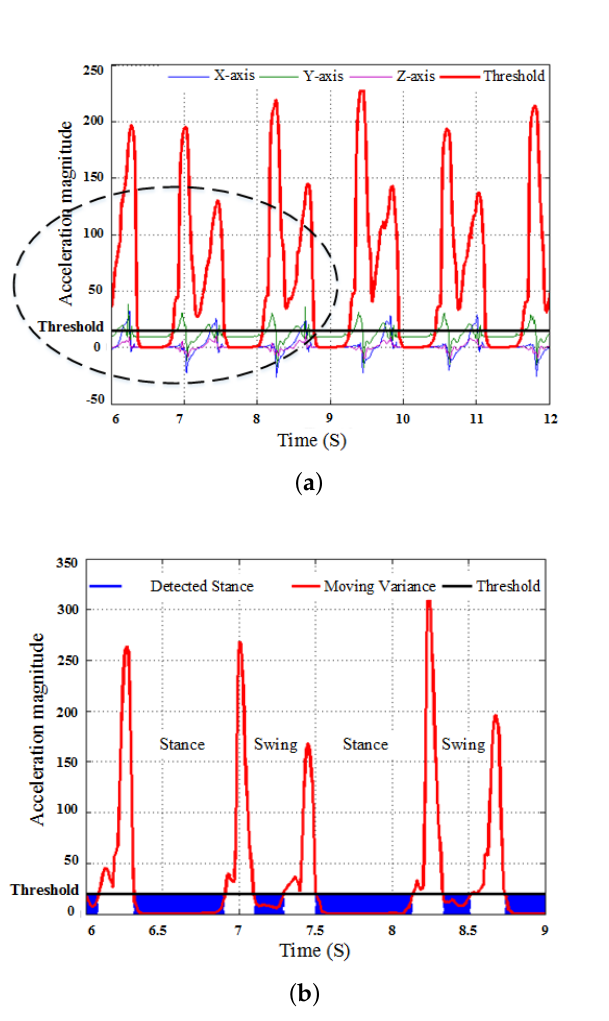
Figure 3. Stance phase detection ( a ) stance phase detection by raw data; ( b ) close-up